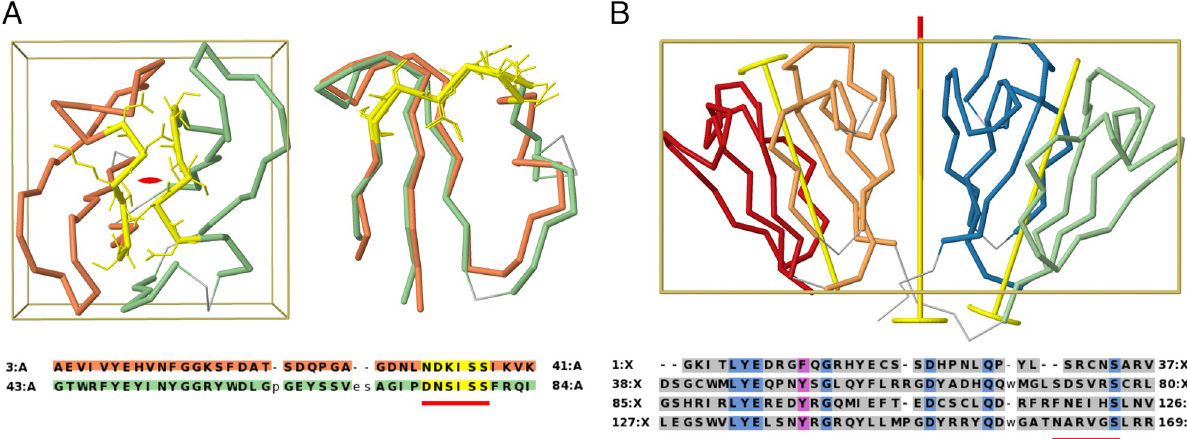
Fig 3. Internal symmetry in crystallin proteins. A) An archaean βγ -crystallin with two repeats per chain (3HZ2). The full chain is displayed along its 2-fold axis, followed by a superposition of the repeats. The conserved calcium binding motif N/D-N/D-#-I-S/T-S is highlighted in yellow throughout. B) Human γ -D crystallin structure with four repeats per chain (1HK0). Two levels of symmetry exist: a C2 symmetry within each globular domain, and an additional C2 axis relating the two domains. The calcium binding motif has been lost (red bar below sequence), but other conserved positions (blue and magenta in the sequence) show the homology between the repeats.